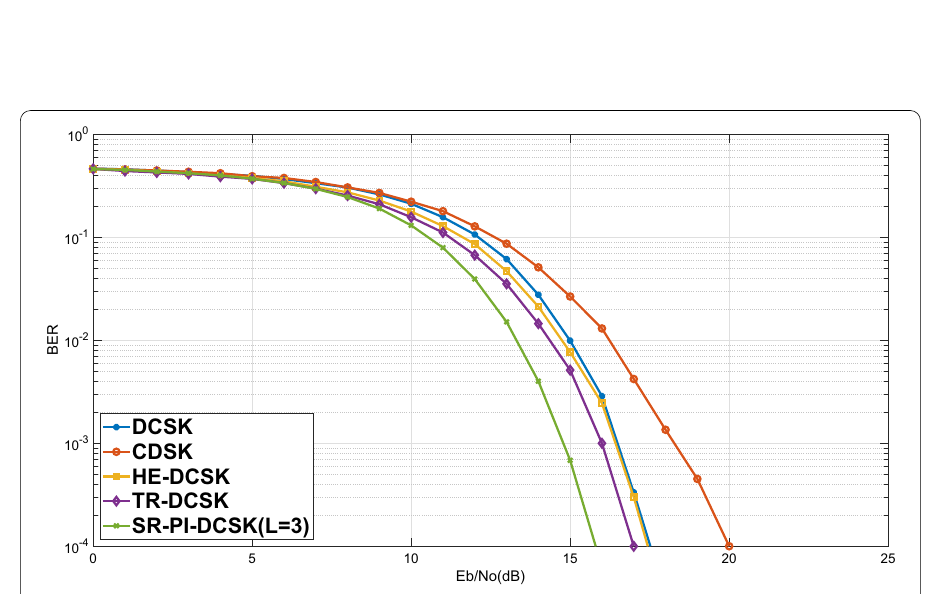
Fig. 5 The bit error rate performance of SR‑PI‑DCSK versus DCSK, CDSK, HE‑DCSK, and TR‑DCSK for β =